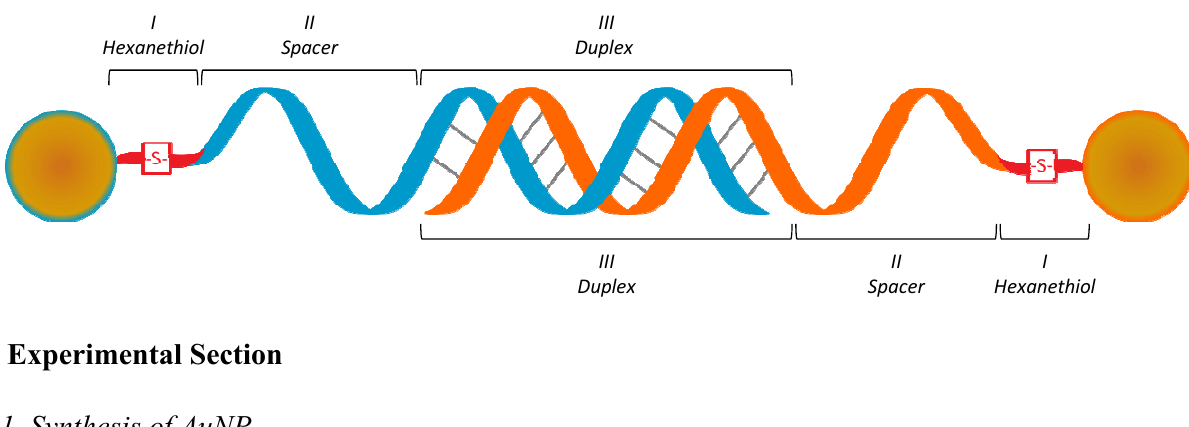
Figure 1. Schematic representation of the assembly of two sets of nanoparticles functionalized with oligonucleotides with complementary